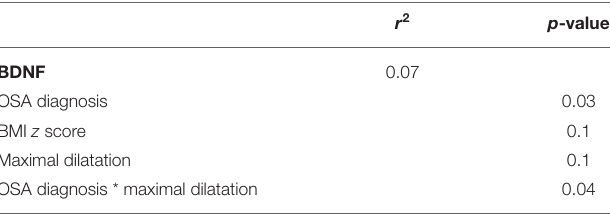
TABLE 3 | General linear model for BDNF with OSA diagnosis, BMI z score and maximal dilatation as factors. r 2 p -value BDNF 0.07 OSA diagnosis 0.03 BMI z score 0.1 Maximal dilatation